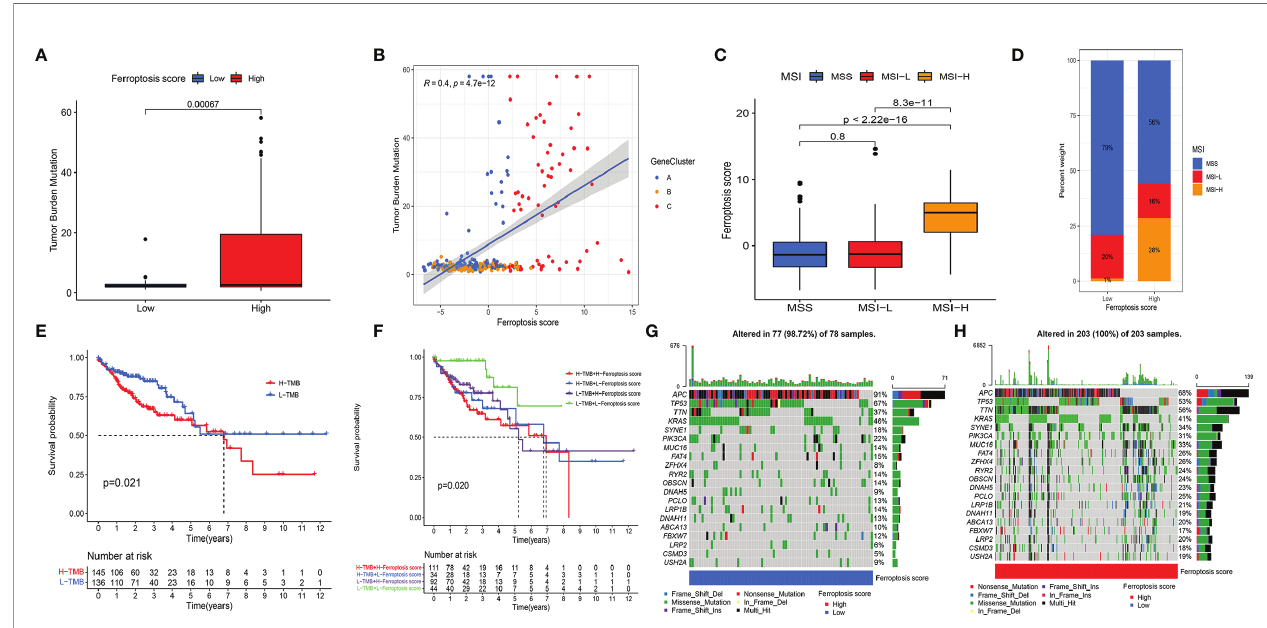
FIGURE 5 | (A) Differences in TMB between HSG and LSG. The Wilcoxon test was used to compare the statistical difference between HSG and LSG ( p < 0.001). (B) The scatterplots show that there was a signi fi cant positive correlation between FS and TMB. The correlation coef fi cient between FS and TMB was 0.4 ( p < 0.001). (C) The median FS in the MSI-H subtype was signi fi cantly higher than that in MSS and MSI-L subtypes (all p < 0.001) (D) The proportion of CC molecular subtypes in HSG and LSG. MSS subtype, blue; MSI-L subtype, red; MSI-H, yellow. (E) Kaplan – Meier curves show an overall survival difference between TMB subgroups ( p = 0.021). (F) Kaplan – Meier curves show overall survival differences strati fi ed by TMB and FS ( p = 0.02). (G, H) The waterfall diagram demonstrates the top 20 driver genes with the highest mutation frequency in HSG (G) and LSG (H) . TMB, tumor mutation burden;